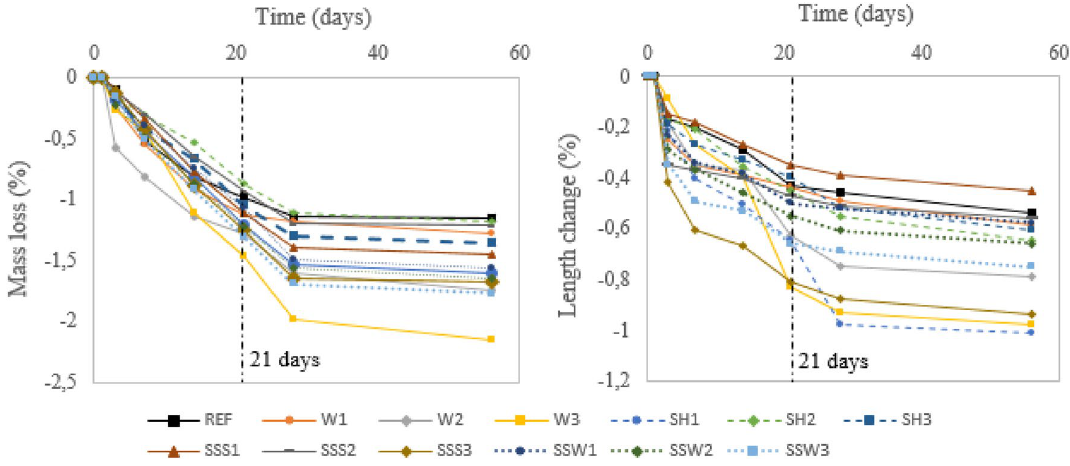
Fig. 4 Mass loss (%) and length change (%) for a period of 56